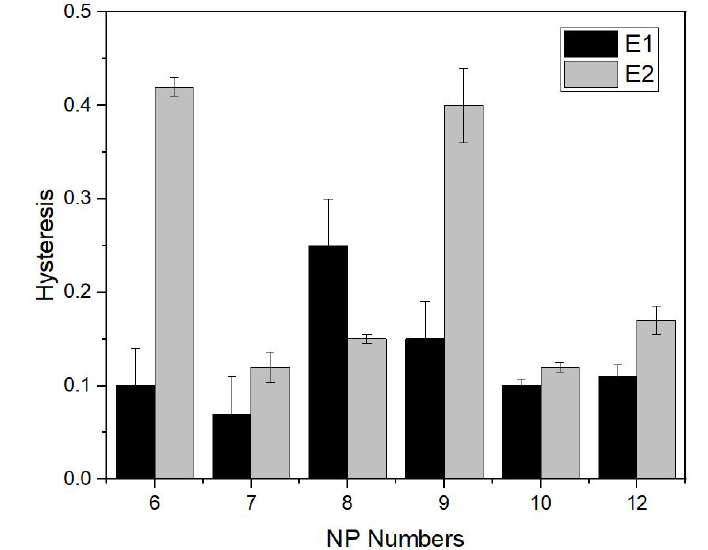
Figure 7. The effect of elastic yarn type (E 1 and E 2 ) on hysteresis for the series of NP x Y S 1 C 2 E 1 and NP x Y S 1 C 2 E 2 . (Hysteresis is calculated according to Equation